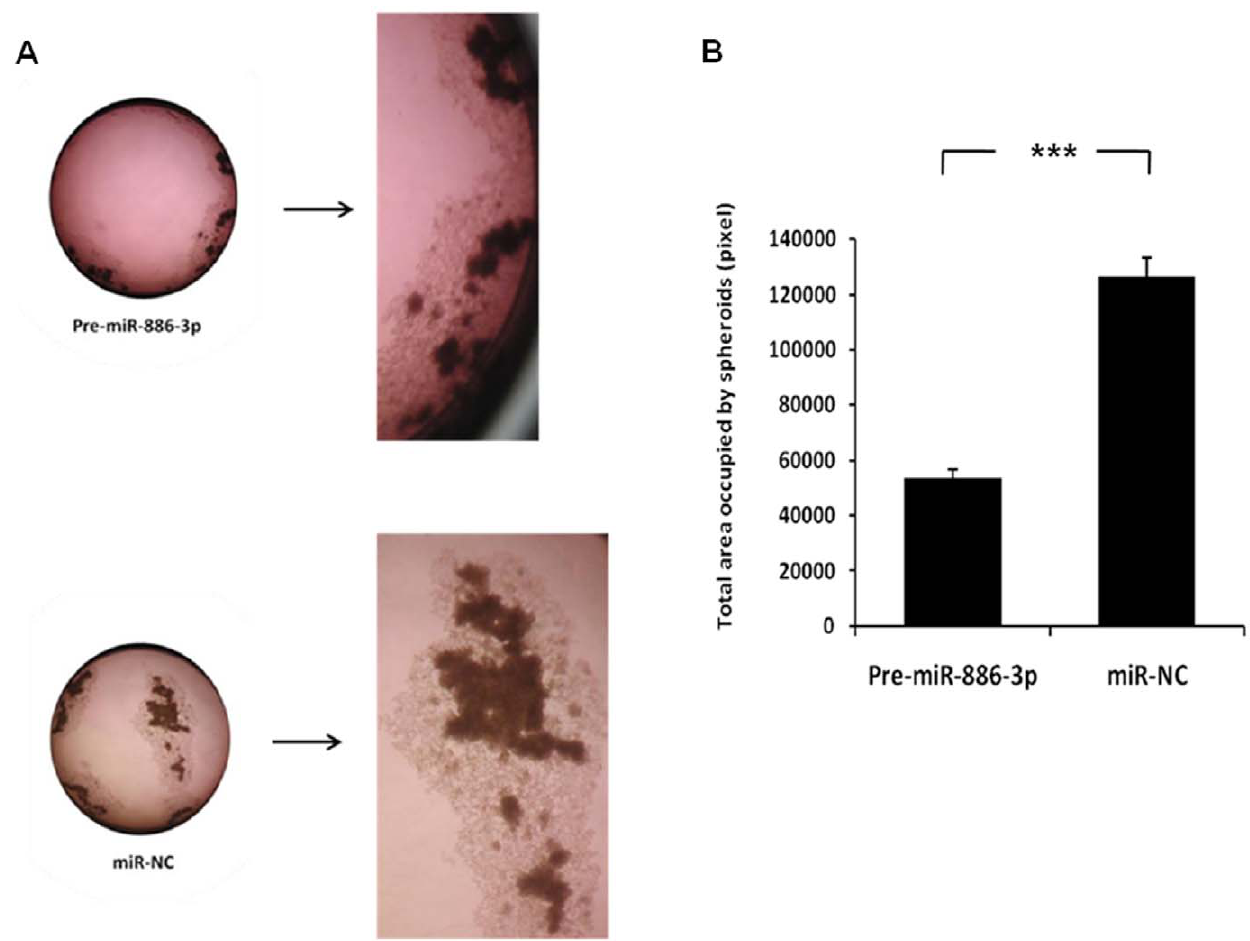
Figure 8. Effect of miR-886-3p overexpression on thyroid cancer cell spheroid formation. Pre-miR-886-3p decreased the size and number of spheroids in the FTC-133 cell line. A ) Representative image of spheroids in culture with miR-886-3p overexpression. B ) Quantification of spheroid difference with miR-886-3p overexpression. The total area occupied by spheroids within an image was measured by circumscribing the perimeter of each spheroid, marking the entire area, and calculating the pixel numbers by using ImageJ software (Maryland, USA). The experiments were repeated three times, and similar results were observed. (*** indicates p , 0.001).